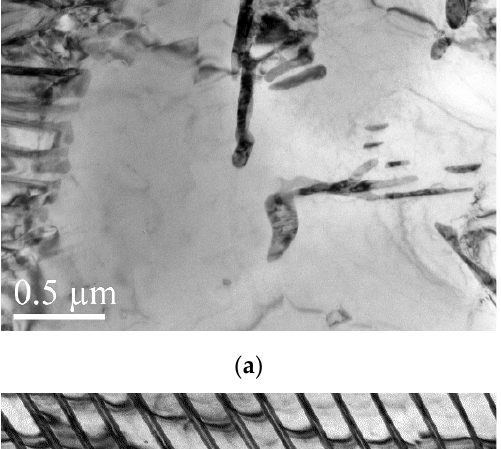
Table 4. The difference in microstructural parameters for the two types of wheel steel.